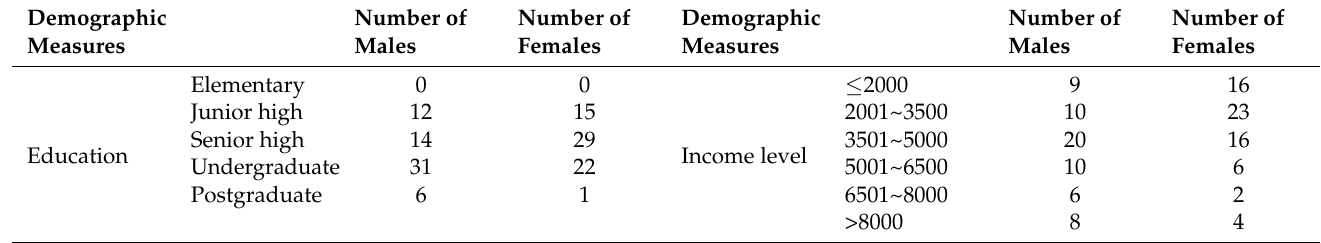
Table 2. Summary of the demographic information (N = 63 +